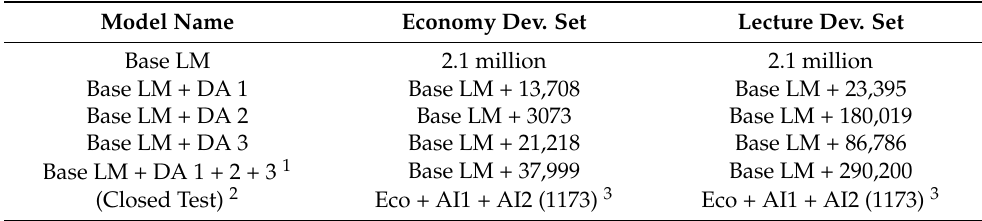
Table 5. The LM corpus for domain adaptation.